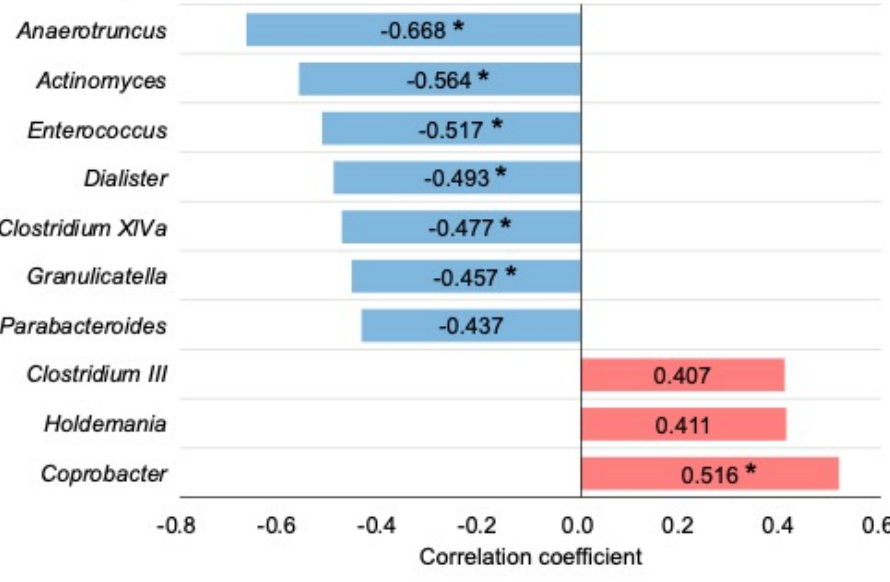
Figure 6. Top 10 gut microbes correlated with logarithmic-transformed TMAO plasma levels. Asterisk shows significant difference at p < 0.05. “LN” indicates a natural